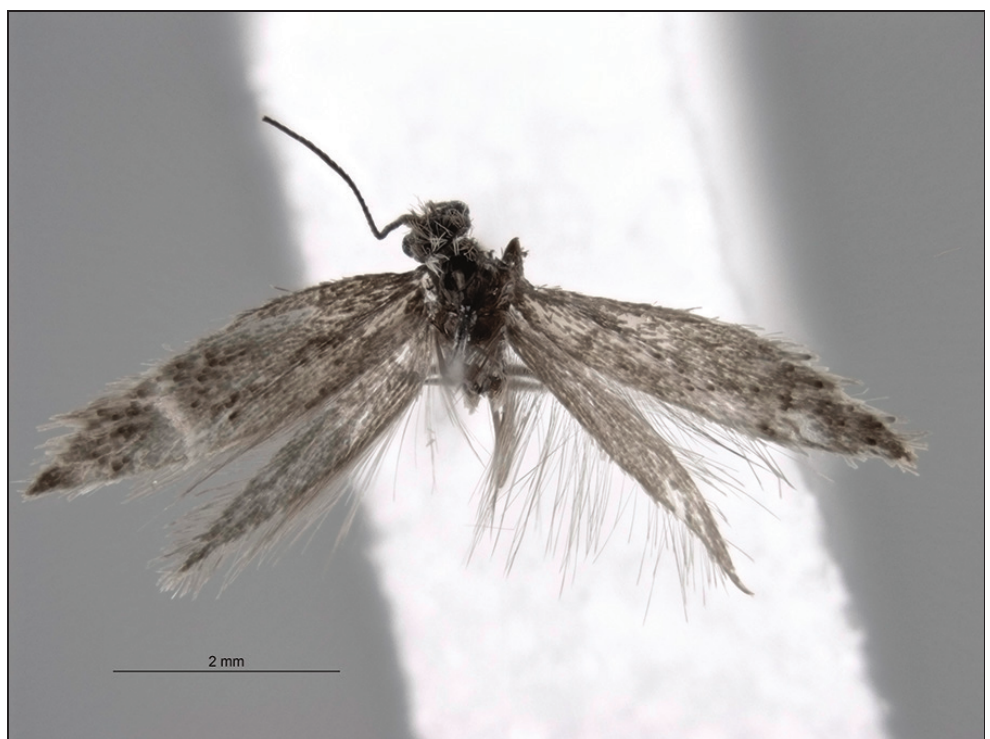
Figure 1. Catapterix tianshanica sp. n., holotype in dorsal view.